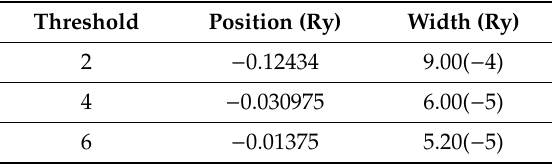
Table 21. Odd parity singlet P states of a Ps −